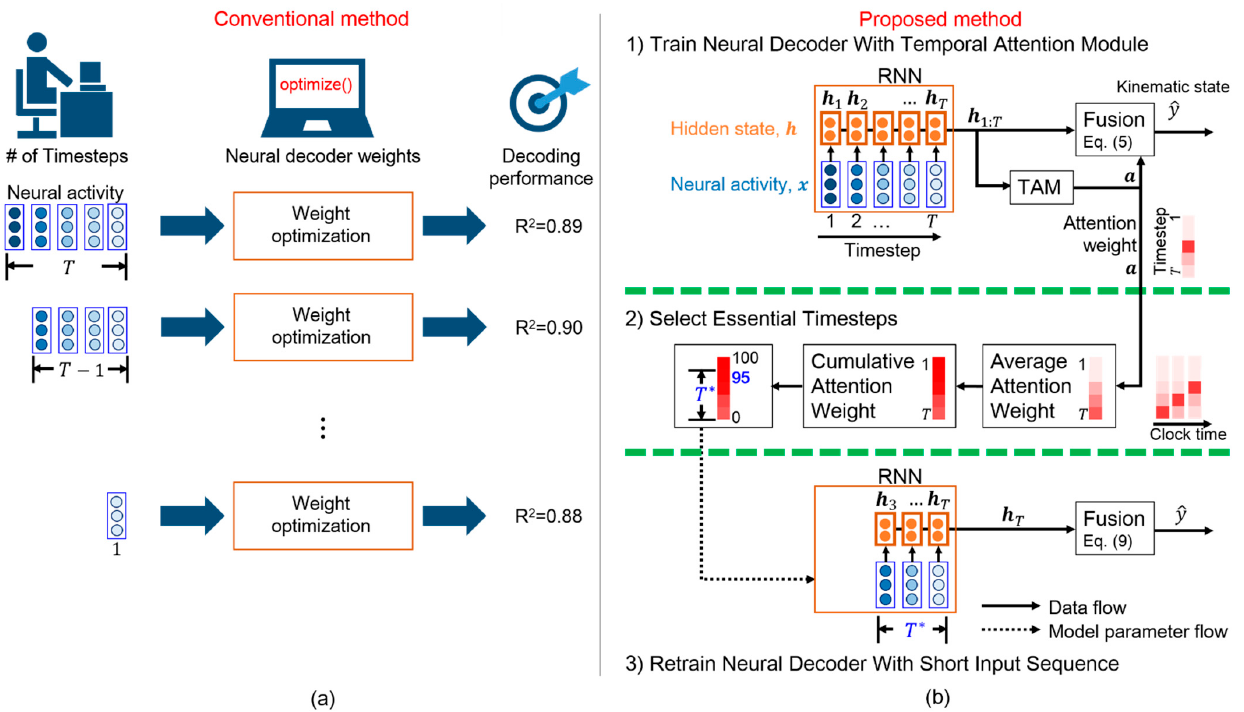
Figure 1. Selection of essential timesteps for neural decoding. ( a ) Conventional method consisting of numerous iterations with high computational cost ( R 2 , coefficient of determination). ( b ) Proposed temporal attention-aware timestep selection (TTS) method. This one-pass method only requires three steps. First, the neural decoder is trained with the temporal attention module (TAM). Next, essential timesteps ( T ∗ ) are selected according to the attention weights. Finally, the neural decoder with a short input sequence of length 𝑇 ∗ is retrained.